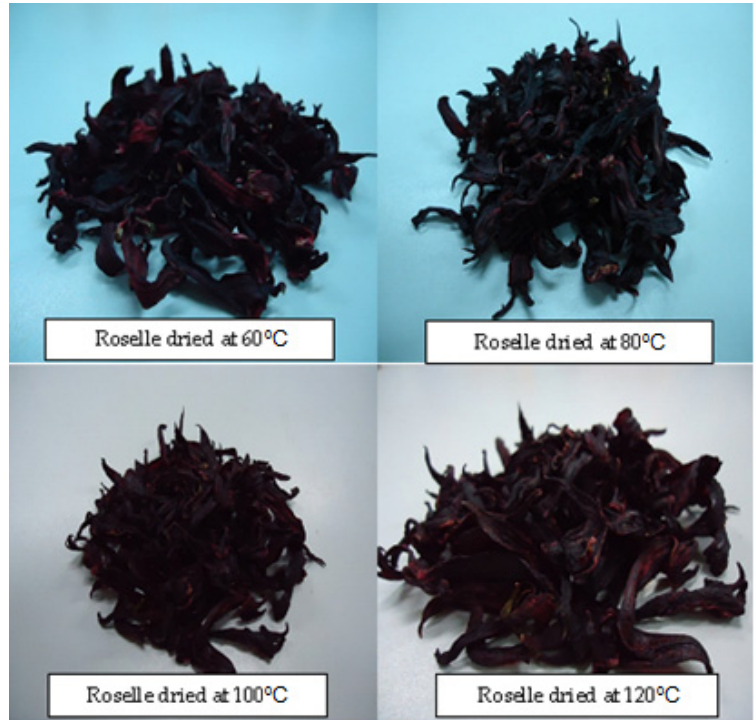
Figure 4. Dried Roselle samples obtained from different drying temperatures.